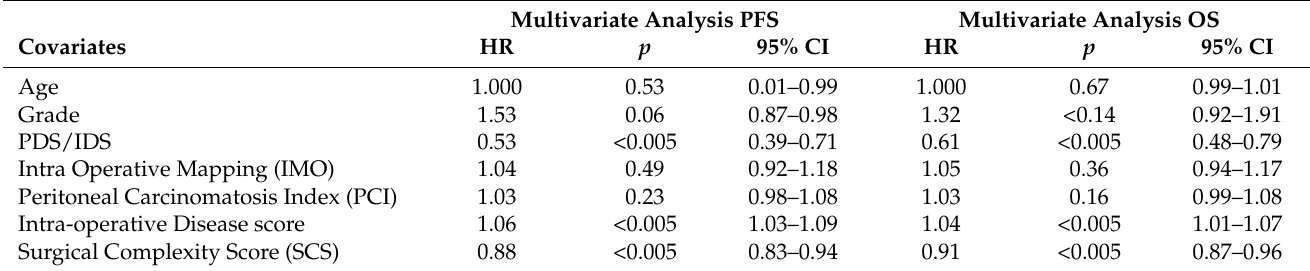
Table 1. Multivariate analysis of covariates for progression-free survival (PFS) and overall survival (OS) based on machine learning-based feature selection.